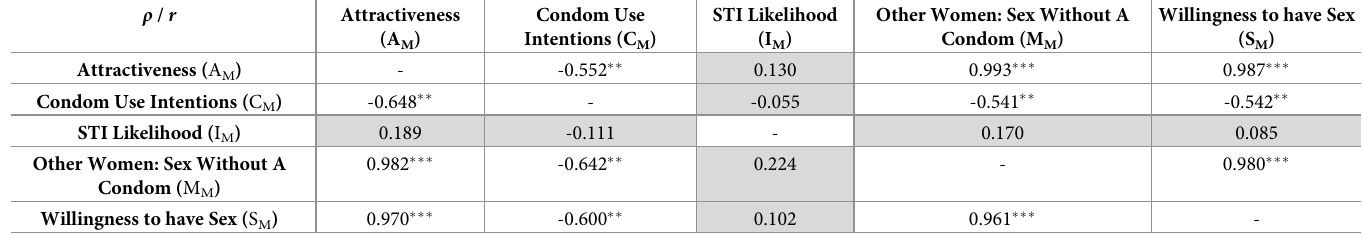
Table 3. Bivariate associations between mean ratings for twenty men (df = 478) of their attractiveness, A M , condom use intentions towards them, C M , their STI like- lihood, I M , the extent to which women like the participants would be willing to engage in condomless sex with them, M M , and the willingness of the participants to have sex with them, S M . Pearson’s r values are shown in the upper right half of the table, Spearman’s ρ in the lower left: � = p < 0.05, �� = p < 0.01, ��� = p < 0.001, grey cells = n.s. ρ /